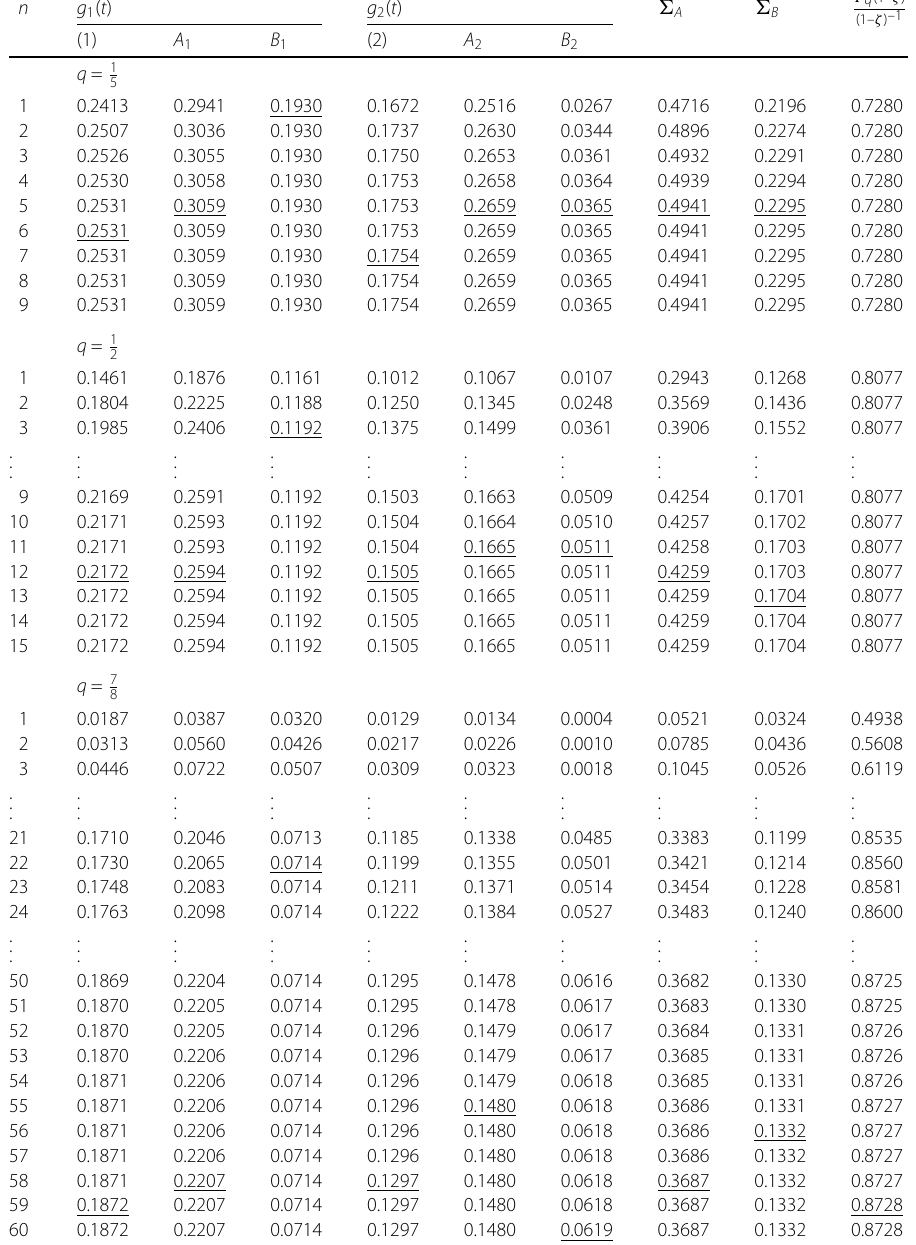
Table 1 Numerical results of problem (59) for q = 1 in Example